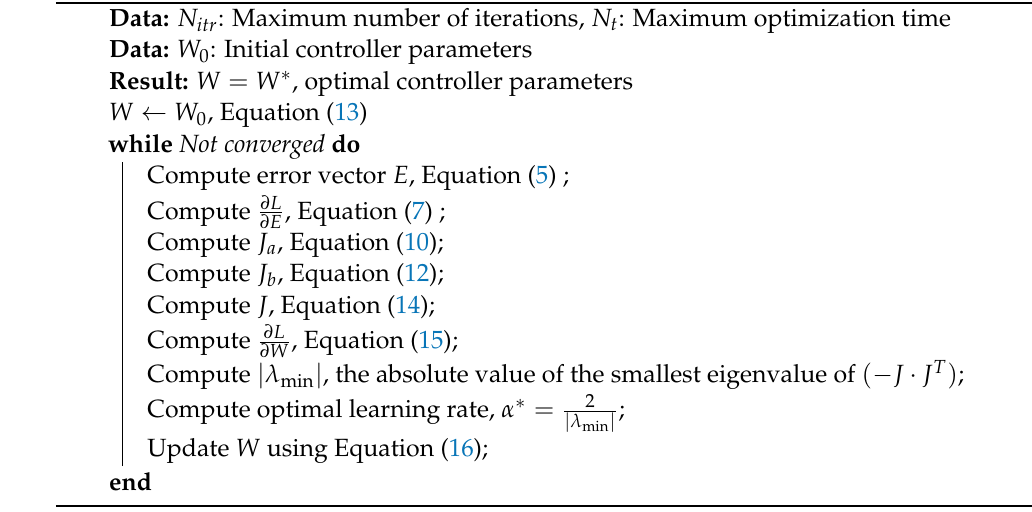
Algorithm 1: Pseudo code of the OCTUNE